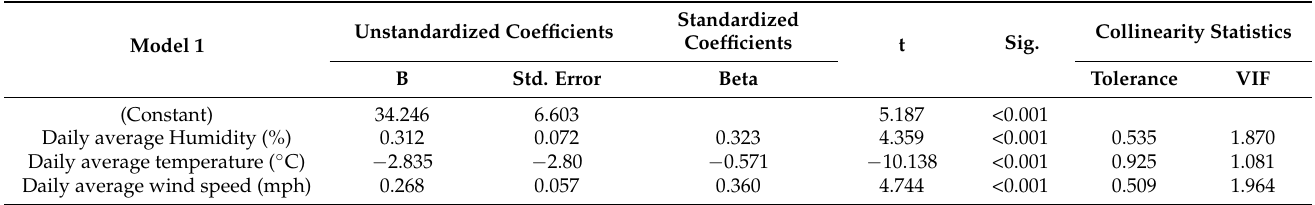
Table 4. Multiple linear stepwise regression model for the prediction of PM 10 (Model 1) and PM 2.5 levels (Model 2) based